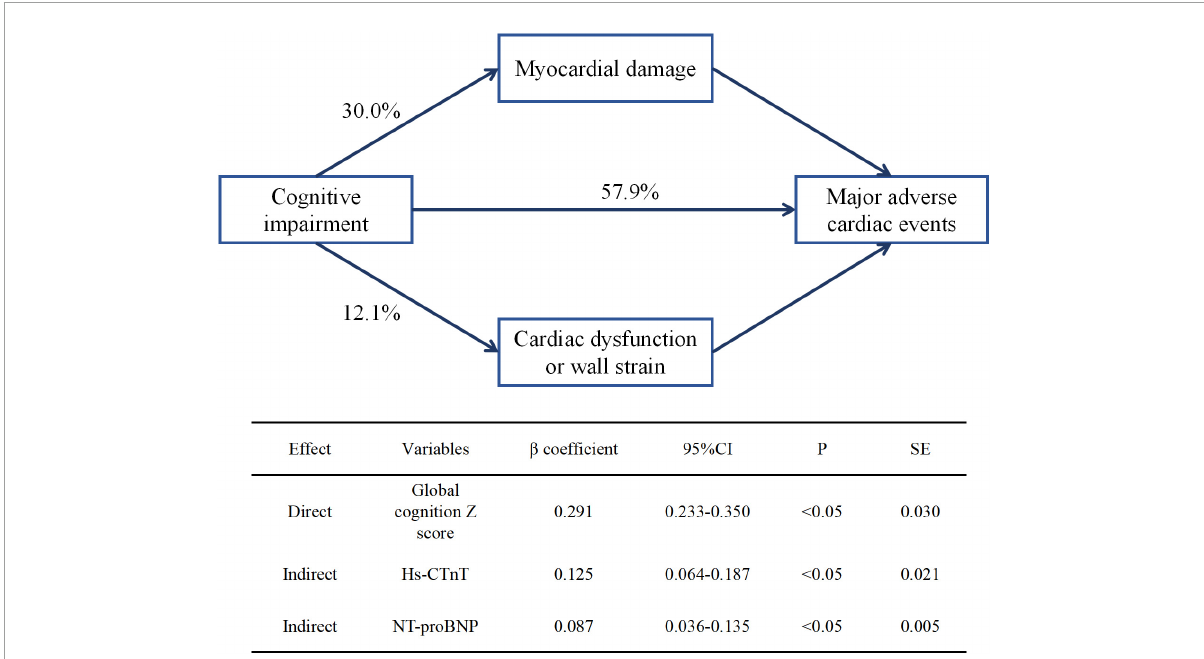
FIGURE2 Direct and indirect effects of global cognition z -score on subclinical cardiovascular disease and long-term major adverse cardiac events. β coefficient was calculated by standard regression equation. hs-CTnT, high-sensitive cardiac troponin T; NT-proBNP, N-terminal pro-B-type natriuretic peptide.